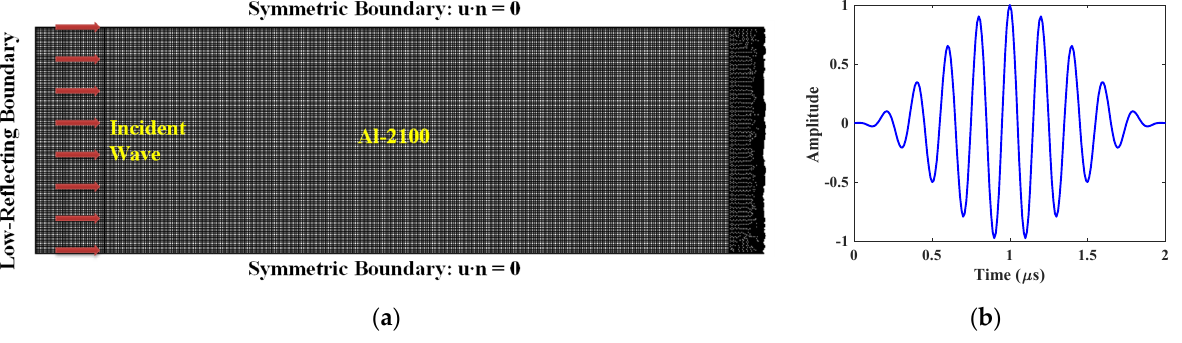
Figure 4. Schematic diagram of FE model: ( a ) geometry model and ( b ) incident waveform.